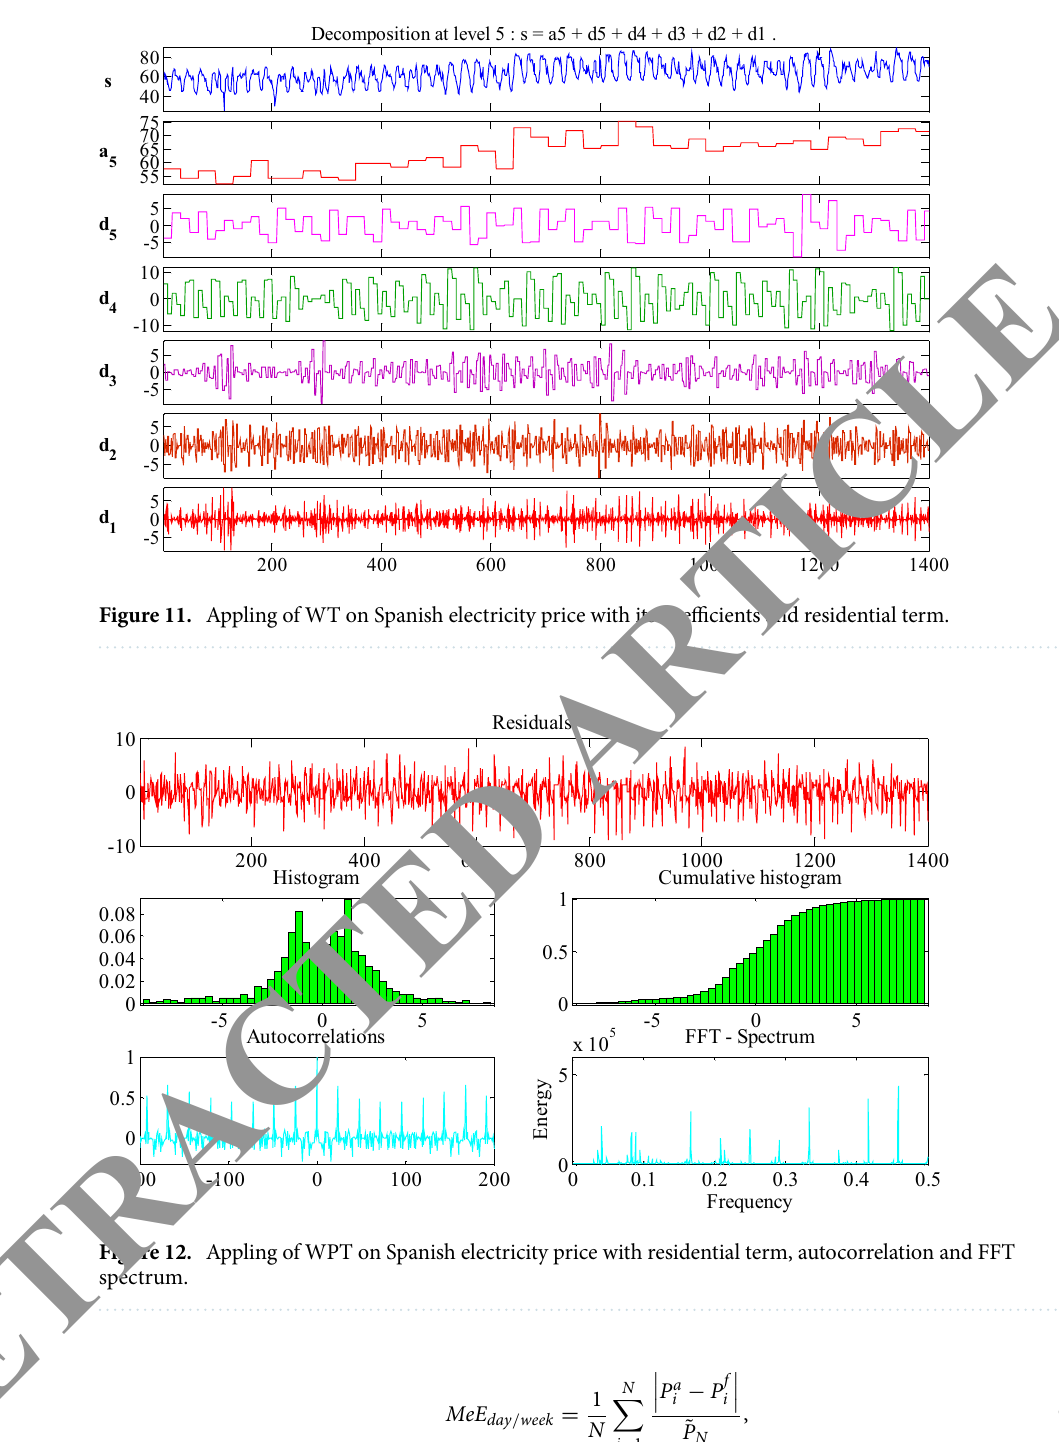
Figure 12. Appling of WPT on Spanish electricity price with residential term, autocorrelation and FFT